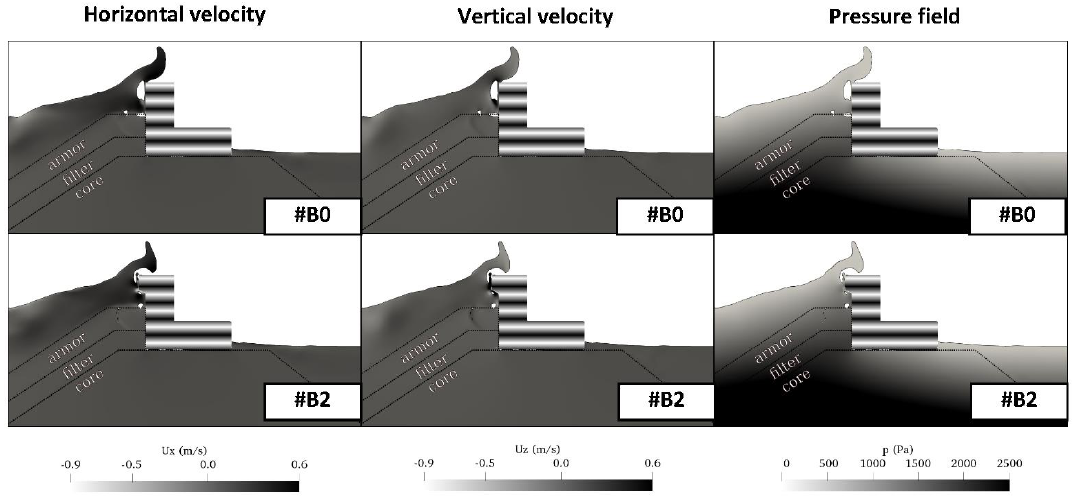
Figure 10. Comparison of pressure field and velocity components. Simulation of 180 s of testing with H m0i = 0.14 m and T p = 3 s, and models #B0 and